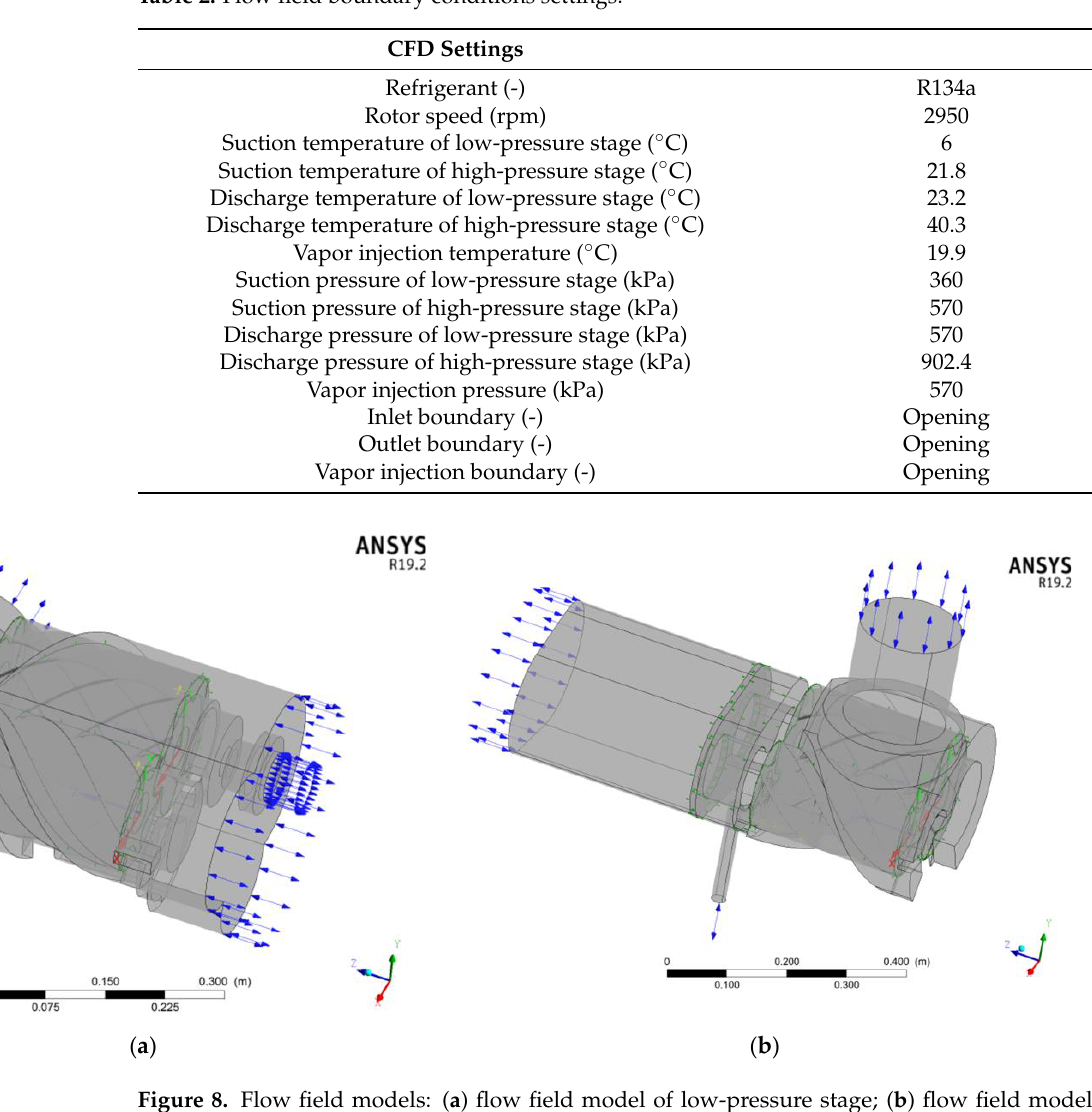
Table 2. Flow field boundary conditions settings.